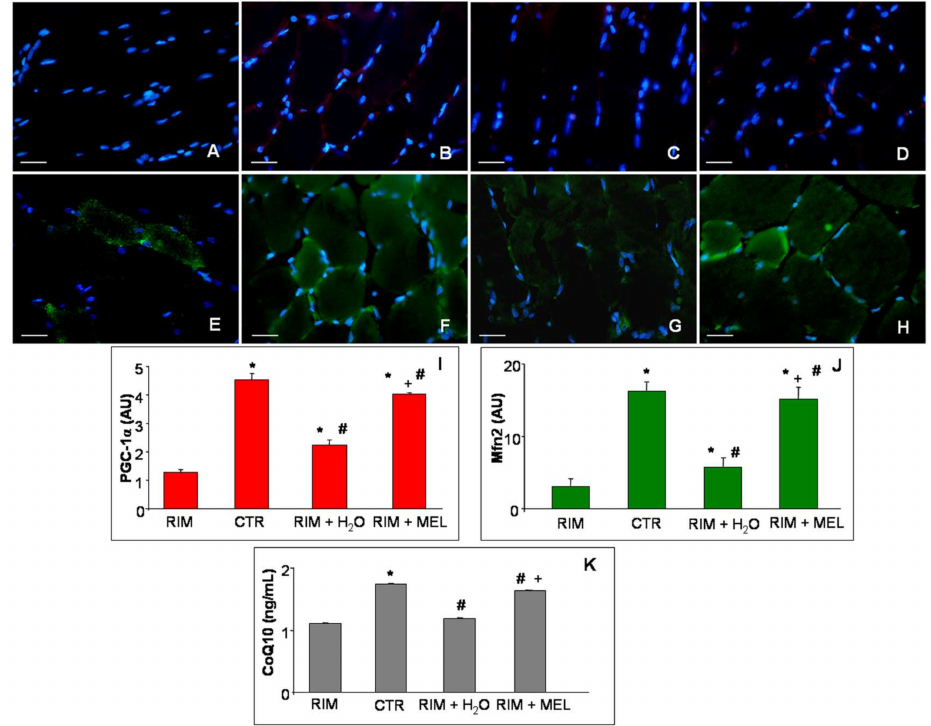
Figure 3. Gastrocnemius mitochondrial markers evaluation. Immunofluorescence photomicrographs of peroxisome proliferator activated receptor gamma coactivator-1alpha ( A – D ) and mitofusin2 ( E – H ) expression in gastrocnemius skeletal muscle of RIM rats ( A , E ), control rats ( B , F ), RIM rats plus tap water ( C , G ) and RIM rats supplemented with melatonin ( D , H ). Bar equal: 20 µ m. The graphs summarize the immunomorphometrical measurement of peroxisome proliferator activated receptor gamma coactivator-1alpha ( I ) and mitofusin2 ( J ) immunopositivities. The graph ( K ) summarizes gastrocnemius coenzyme Q10 level of all experimental groups. * p ≤ 0.05 vs. RIM; # p ≤ 0.05 vs.